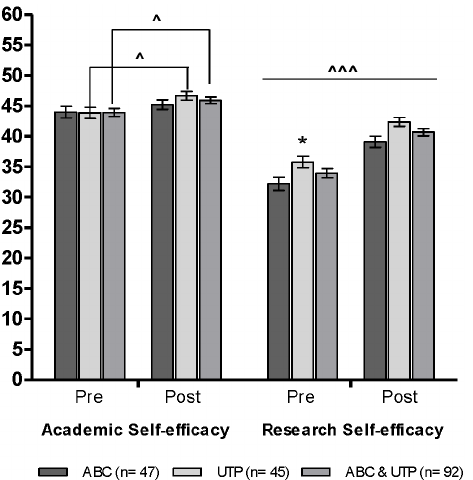
Figure 2. ABC & UTP participant self-assessment of academic and research self-efficacy before and after the summer research experience (2006, 2010–2012). The academic and research self-efficacy variables are presented as means 6 SEM (maximum possible is 60). * p , 0.05 for the Pre mean comparison between the ABC and the UTP group. ‘ p , 0.05 for the Pre to Post paired mean comparison for the indicated group. ‘‘‘ p , 0.001 for the Pre to Post paired mean comparison for all of the groups.